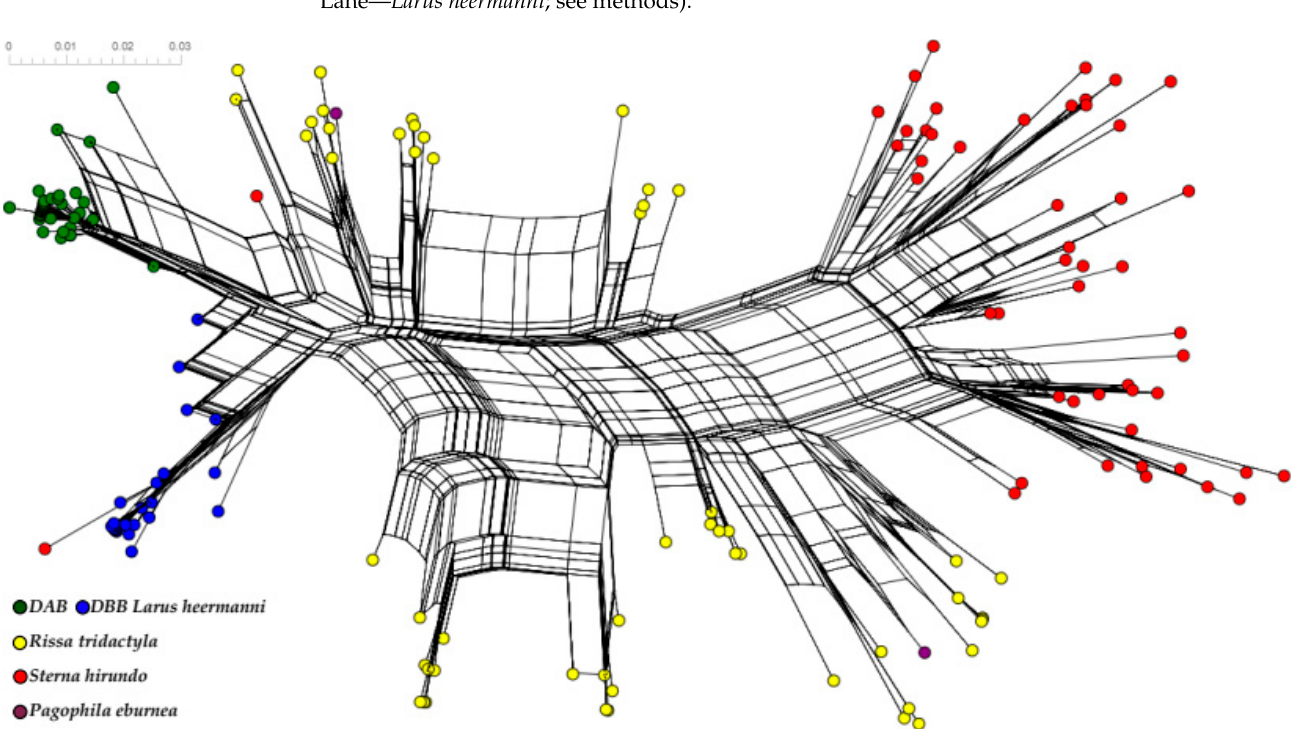
Figure 9. Neighbor-net phylogenetic networks for MHCIIB exon 2 alleles in Laridae species.